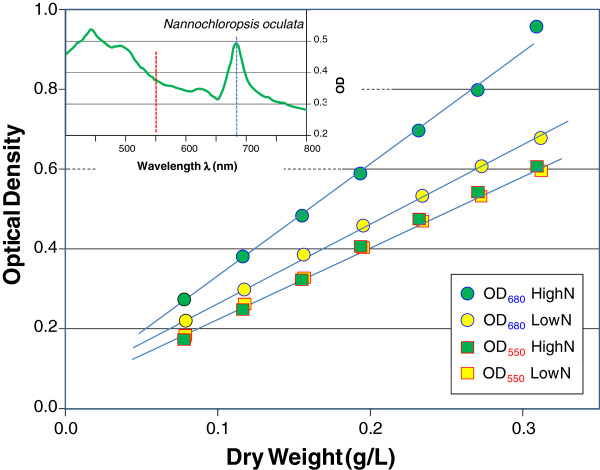
OD measurements which avoid absorption peaks provide robust biomass correlation. Correlation between biomass density and optical density for Nannochloropsis algae cultures grown on high and low nitrogen to alter the chlorophyll content. Measurements corresponding to chlorophyll absorbance (~680 nm, figure inset) display very different correlation as compared to the correlation at the robust wavelength (ODR) of 550 nm.